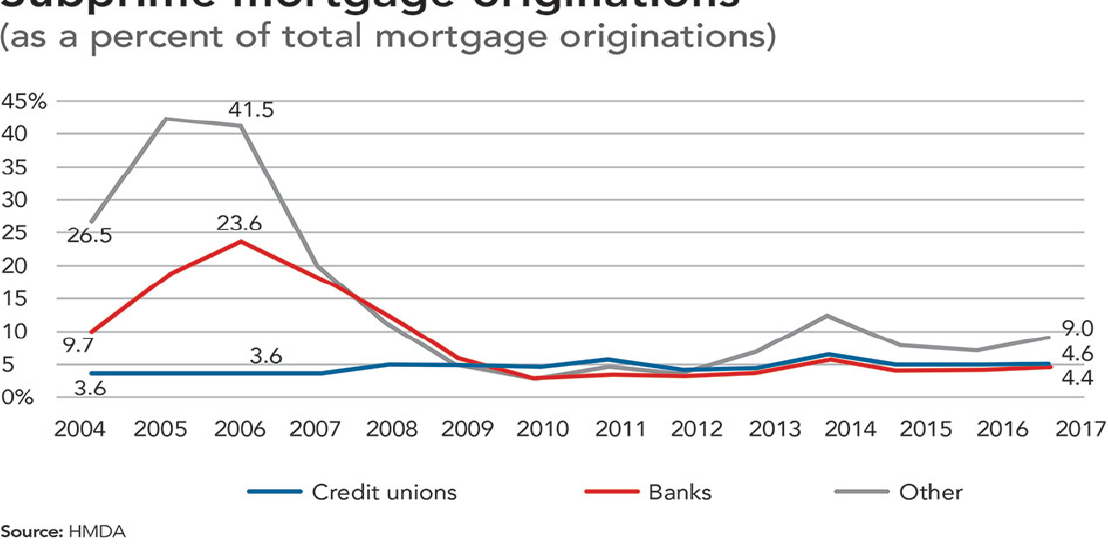
Figure 4. Subprime Mortgage Originations.